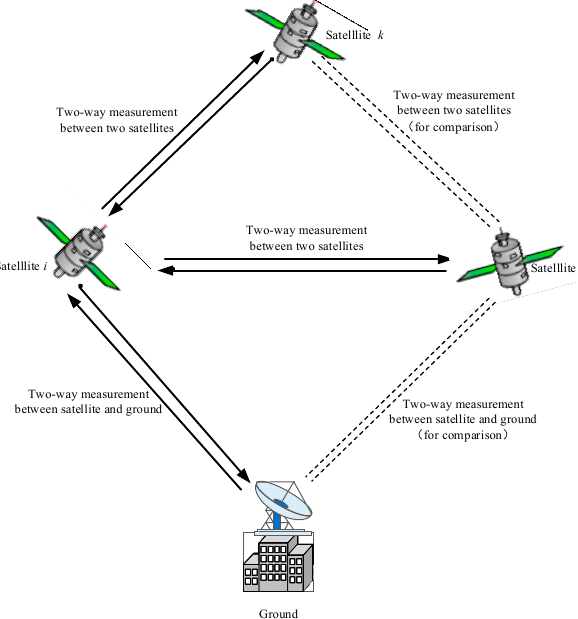
Figure 3. Schematic diagram of inter-satellite station closure error.